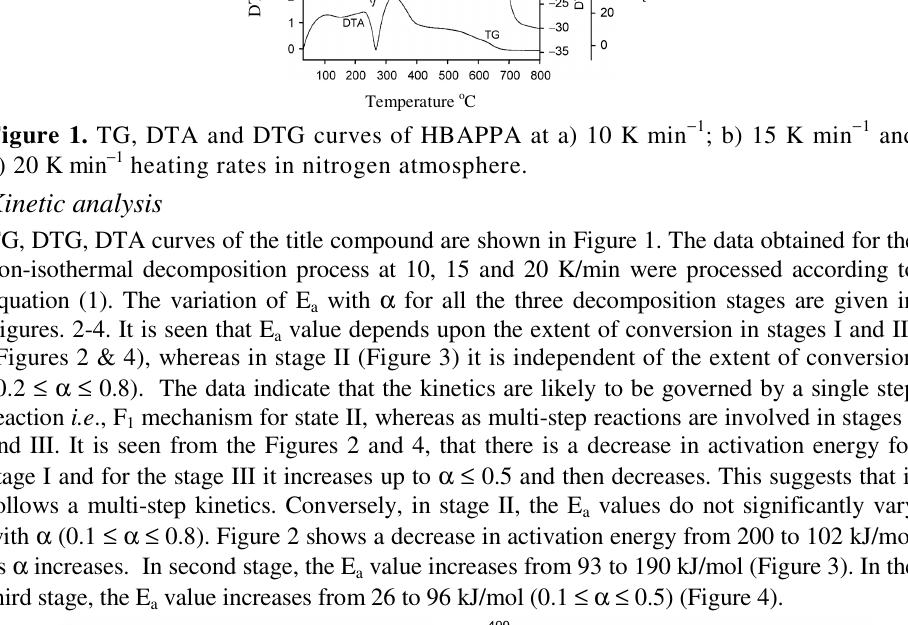
with α for the a